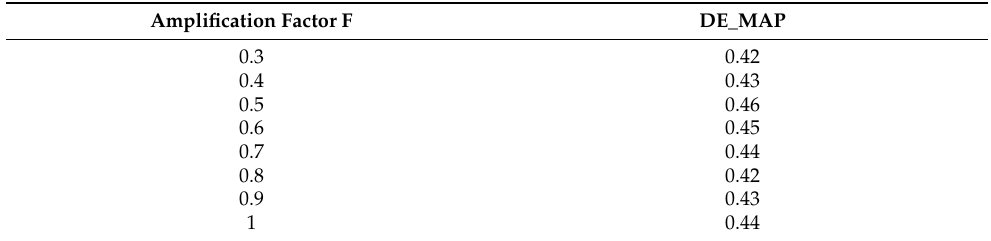
Table 5. F parameter tuning. This table presents MAP@10 for different parameter values. The remaining parameters are set to the default values according to Table 1.